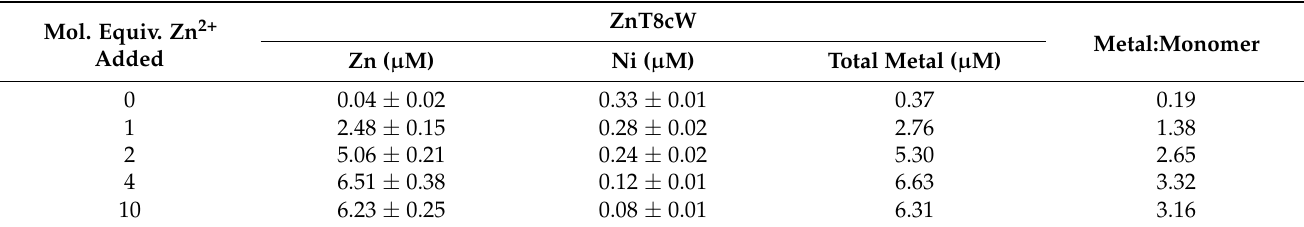
Table 2. Metal analysis (ICP-MS) of zinc and nickel content of 2 µ M monomeric ZnT8cW after gel filtration following incubation with 0–10 molar equivalents of Zn 2+ (n = 3).